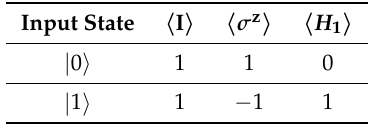
Table 1. Single-qubit mapping table to obtain H 1 mapped from f 1 ( x )